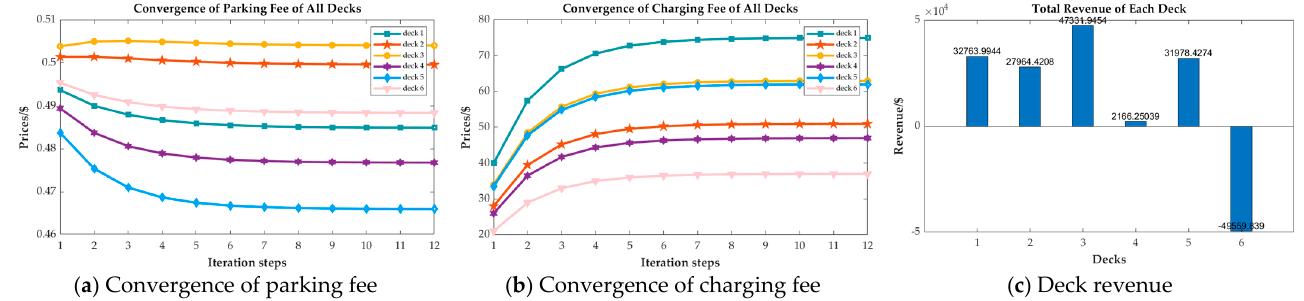
( c ) Deck revenue Figure 4. The charging price, parking fee, and total revenue after the number of SC customers in deck 6 was reduced to zero. In the above case, we studied the impact of changes in customers of one deck on the pricing strategies and revenues of other decks. Next, we studied the impact of pricing